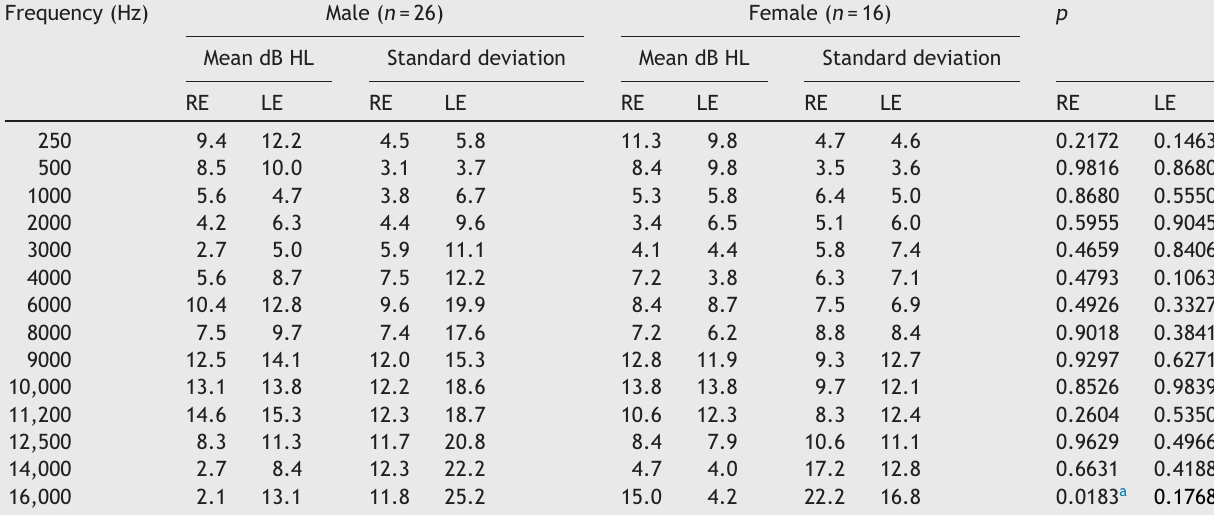
Table 3 Mean pure-tone air-conduction hearing thresholds of right and left ears, per frequency, between male and female genders ( n = 42).